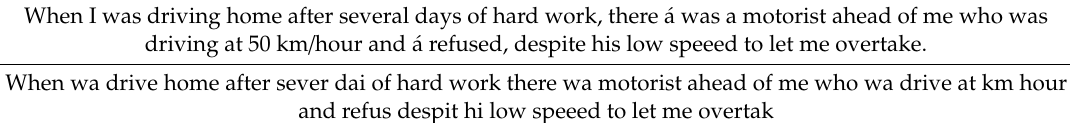
Table 1. Sample sentence from the anger category before and after